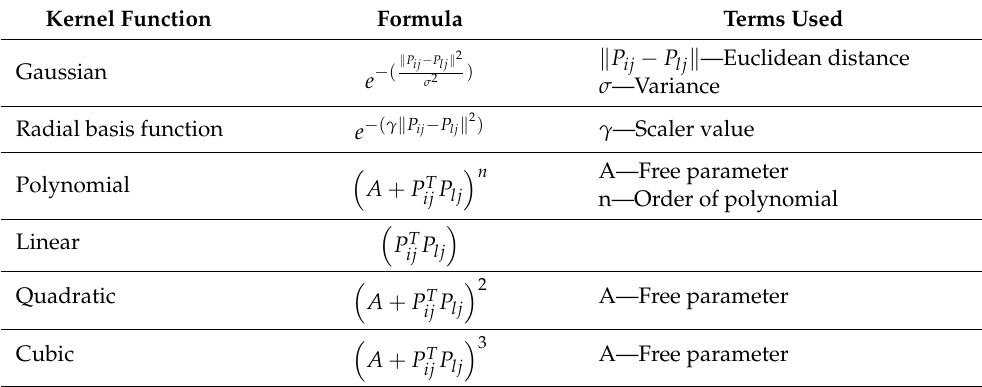
Table 2. Kernel functions and their